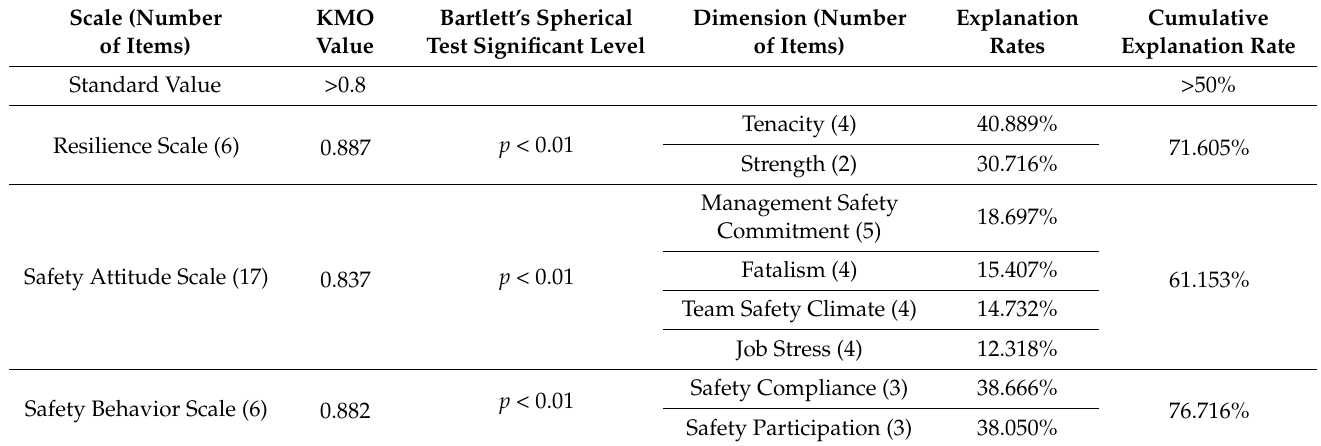
Table 2. KMO coefficient, Bartlett’s test, and factor analysis of the three scales.